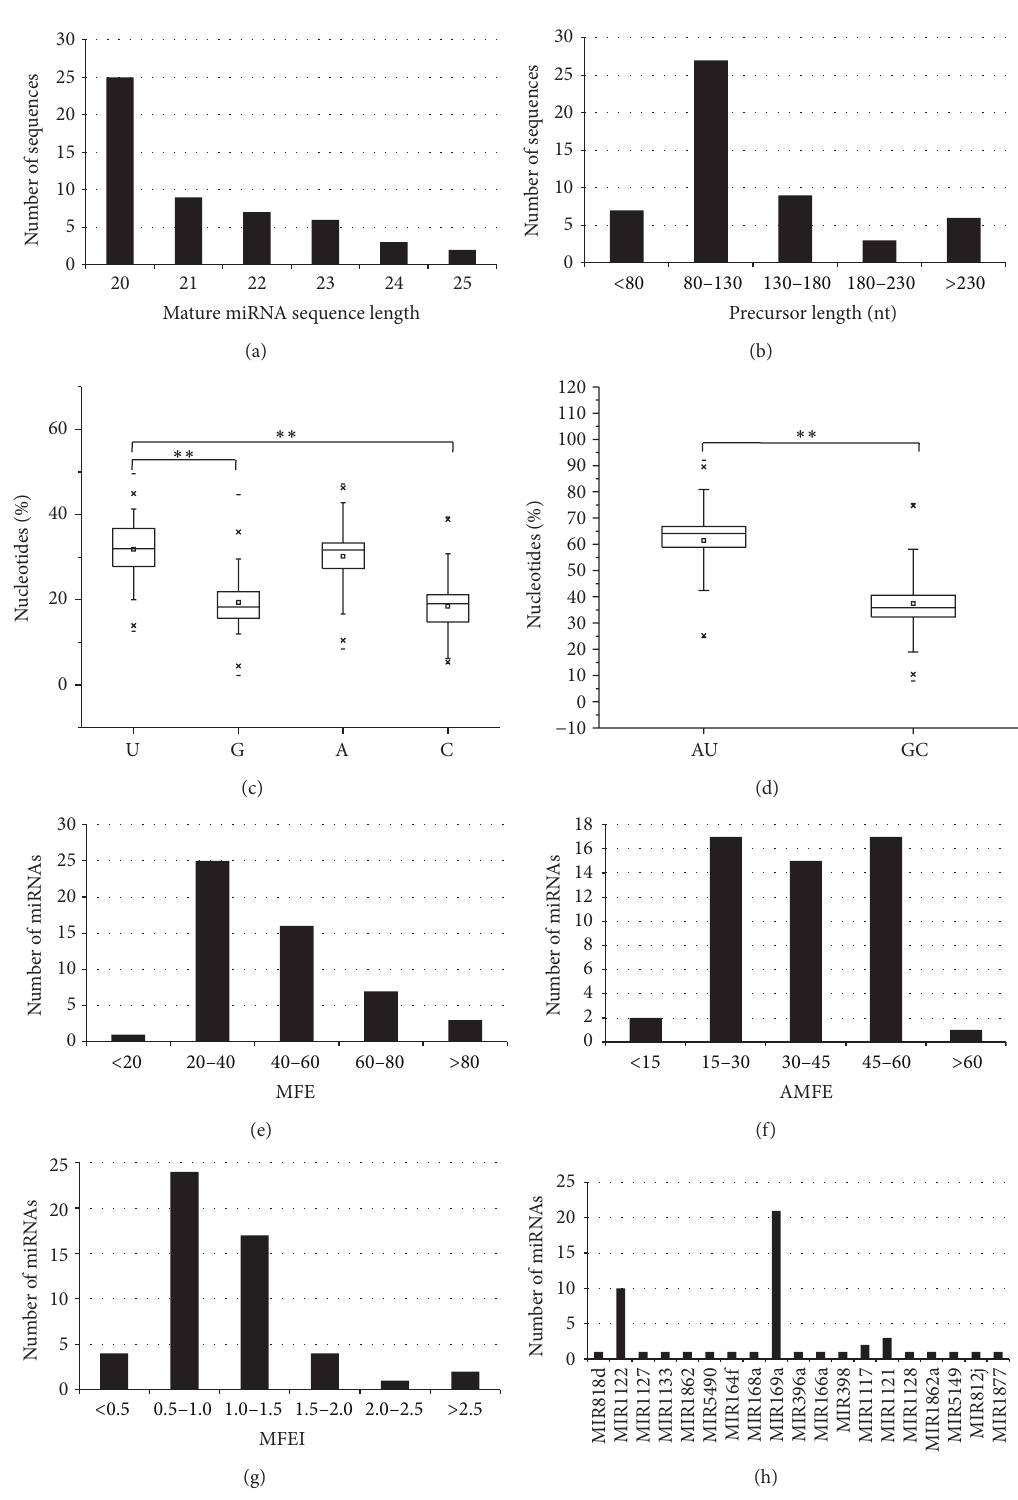
Figure 2: Characterization of miRNAs identified in wheat. Length distribution of mature miRNAs (a) and pre-miRNAs (b); the distribution of four nucleotides (c and d), MFE (e), AMFE (f), and MFEI (g) in the pre-miRNA sequences and miRNA families